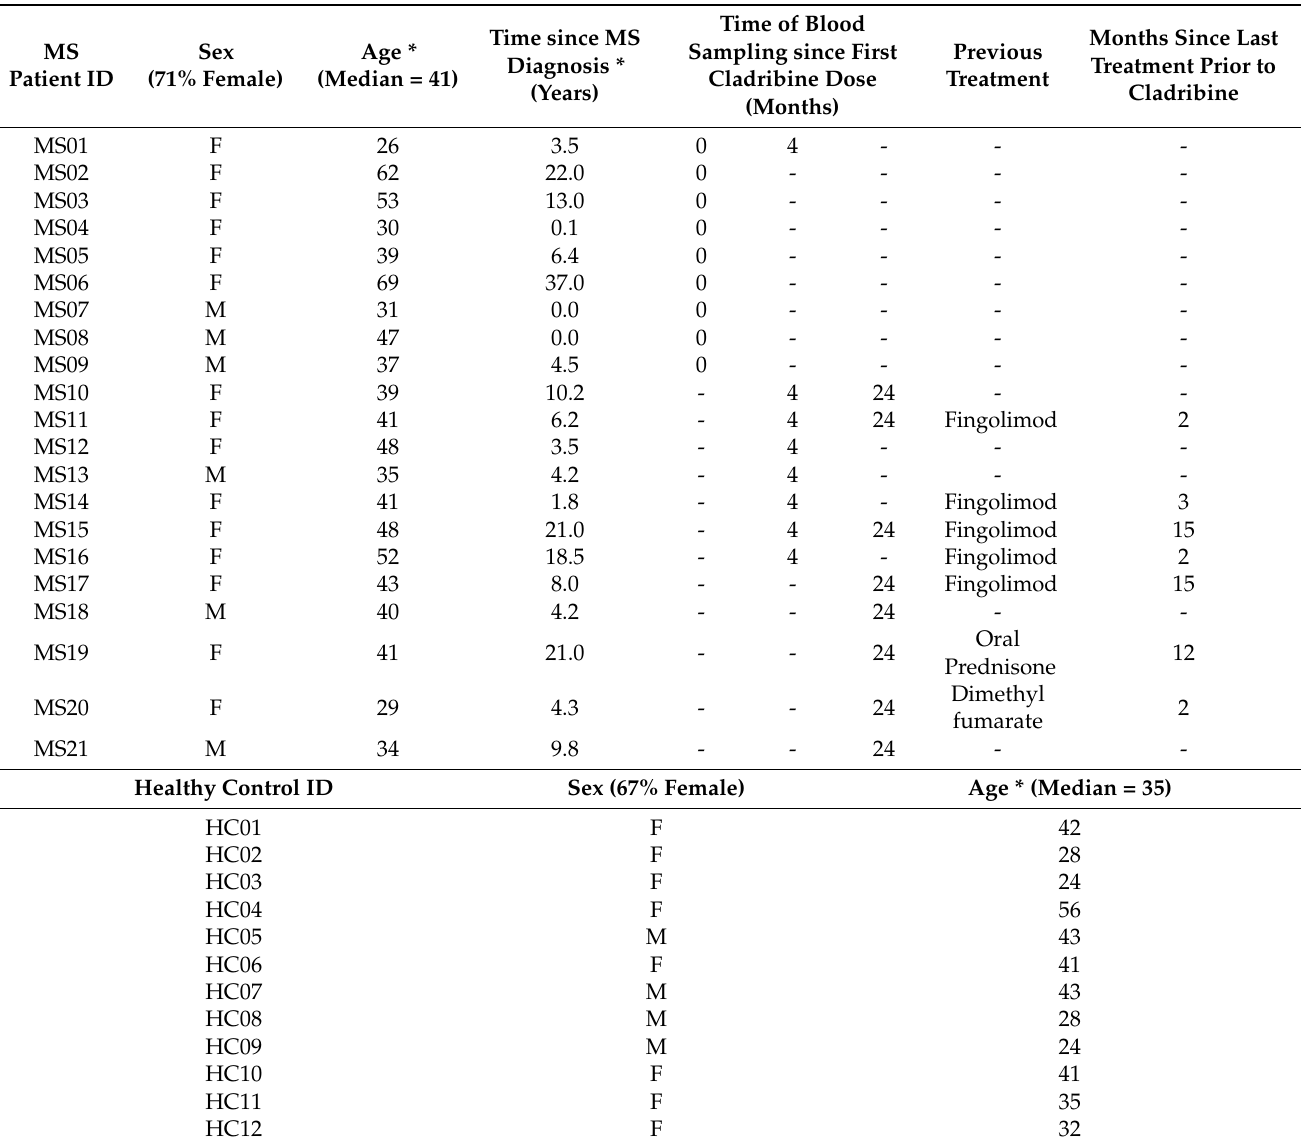
Table 1. Overview of demographic and clinical data on MS patients and healthy volunteers from which samples were collected for use within this